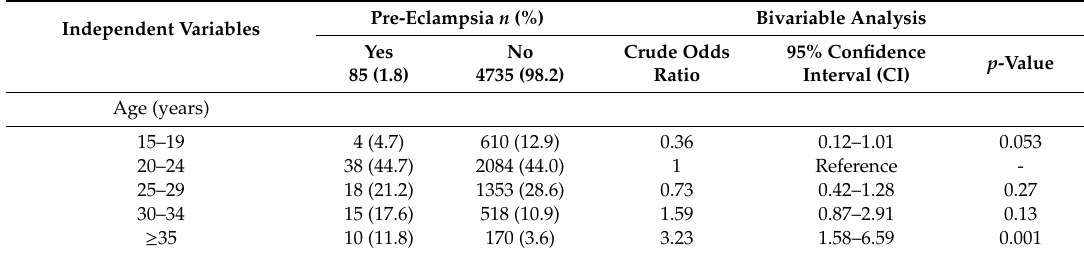
Table 1. Distributions of factors associated with pre-eclampsia and Bivariable logistic regression analysis